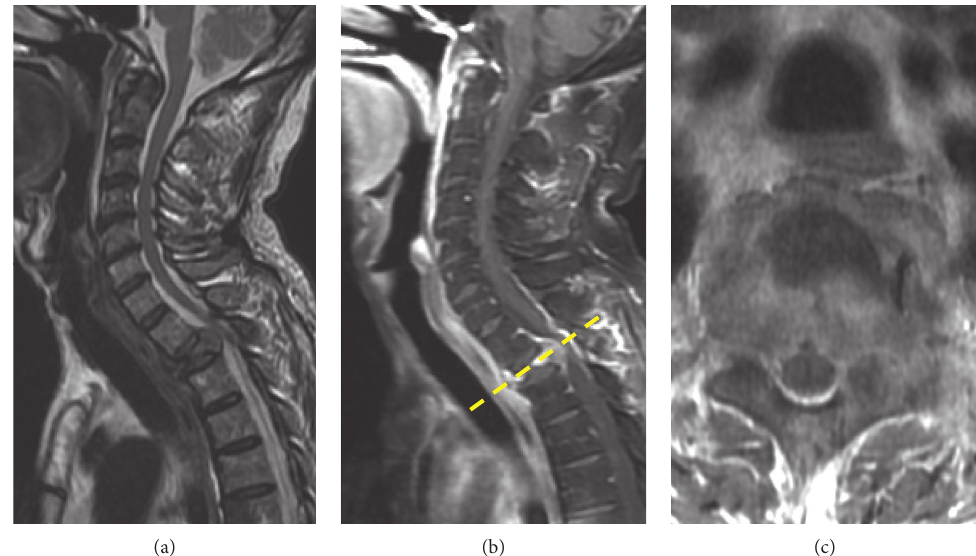
Figure 2: The patient presented spinal tumor at the T2 level with cord compression. (a) T2-weighted, (b) T1-weighted with a contrast sagittal view, and (c) T1-weighted with a contrast axial